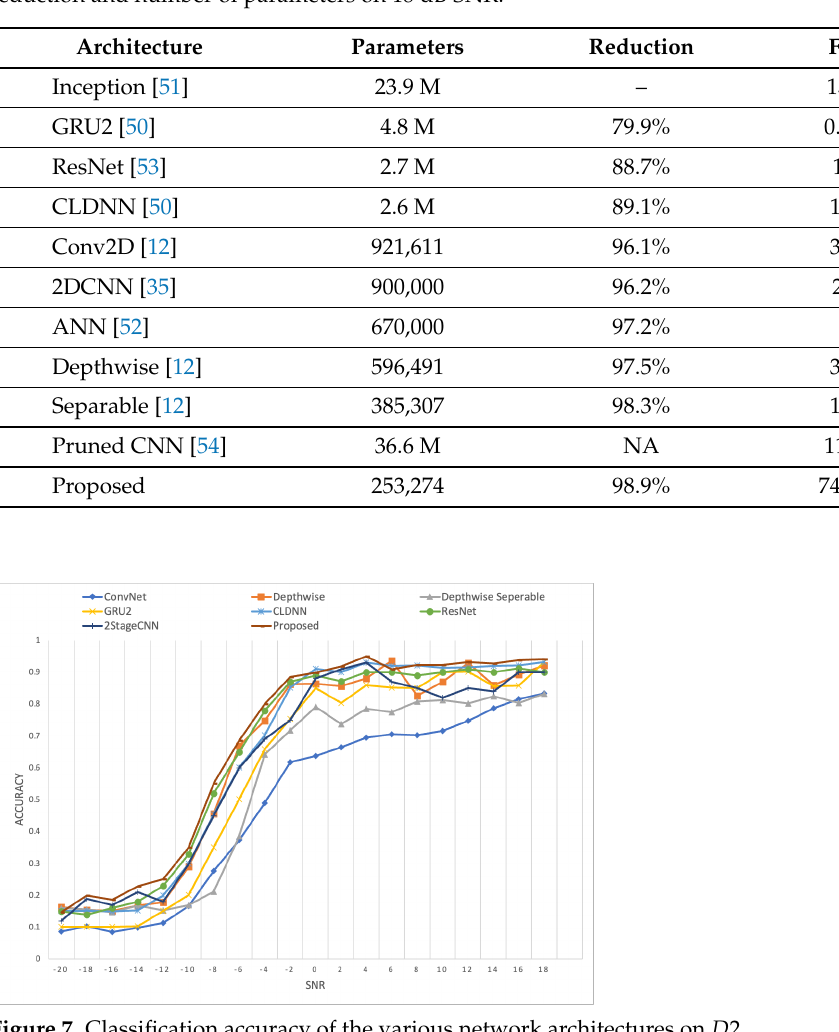
Figure 6. Classification accuracy of the various network architectures on D 1. Table 2. Comparison of proposed method with contemporary approaches in terms of parameter reduction and number of parameters on 18 dB SNR.